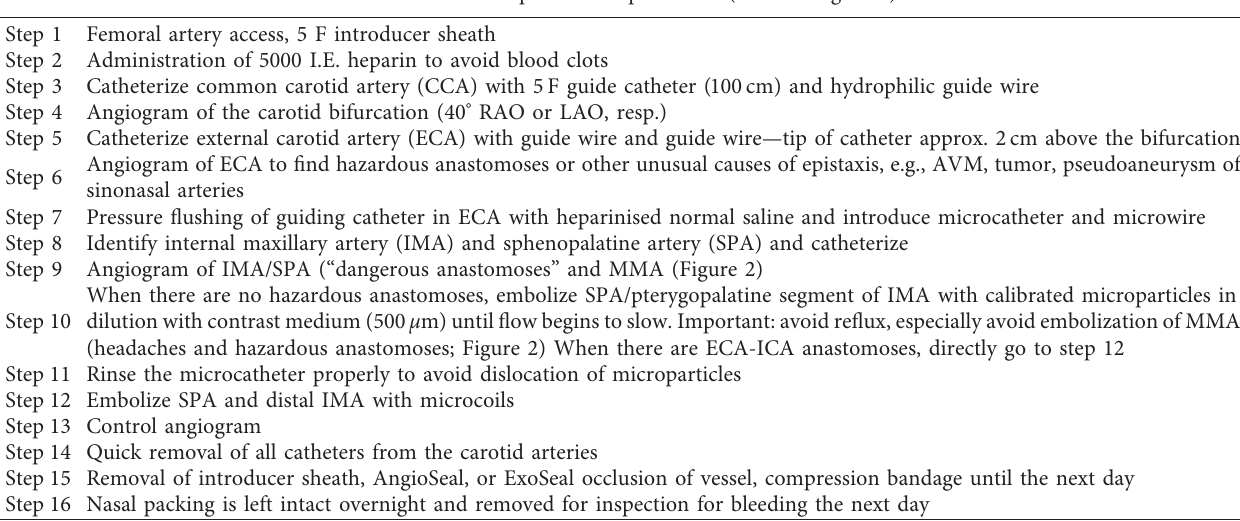
Table 2: Standard protocol of procedure (see also Figure